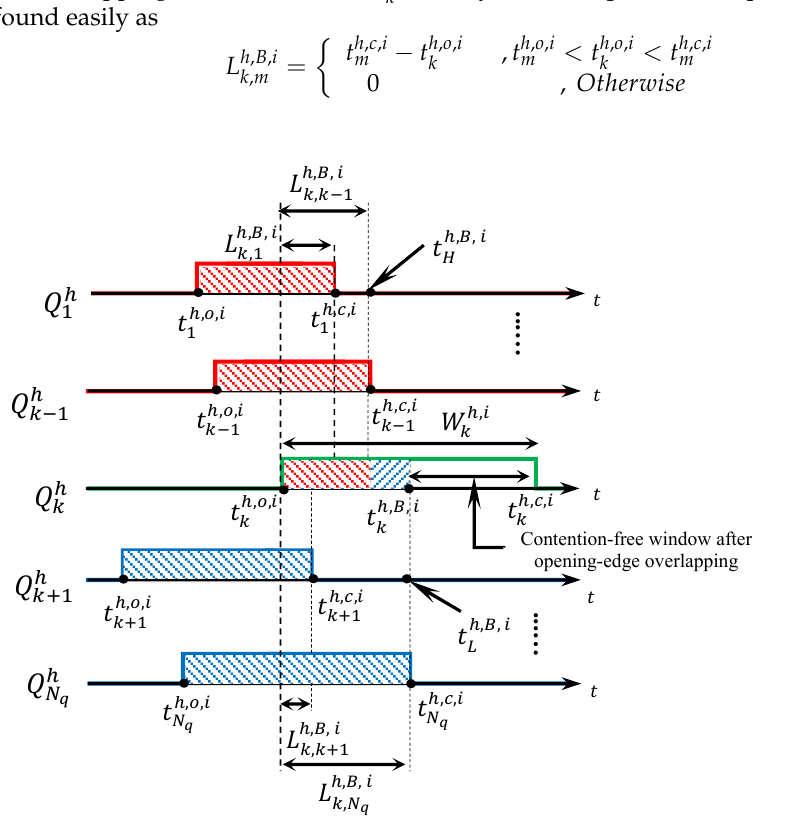
Figure 7. Opening-edge overlapping with higher- and lower-priority windows.